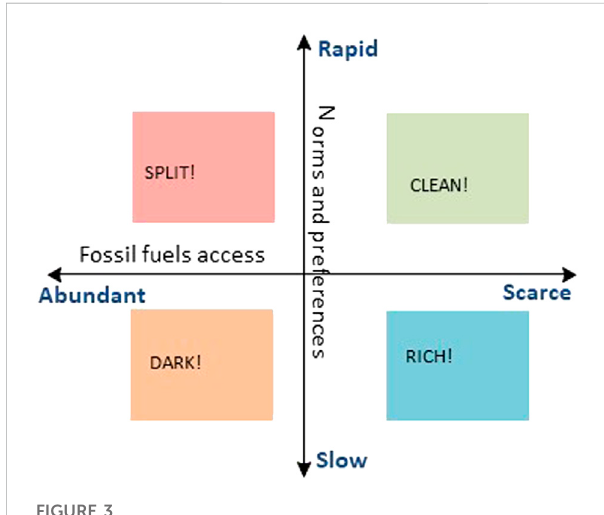
FIGURE 3 Scenarios. Source; Fæhn and Stoknes